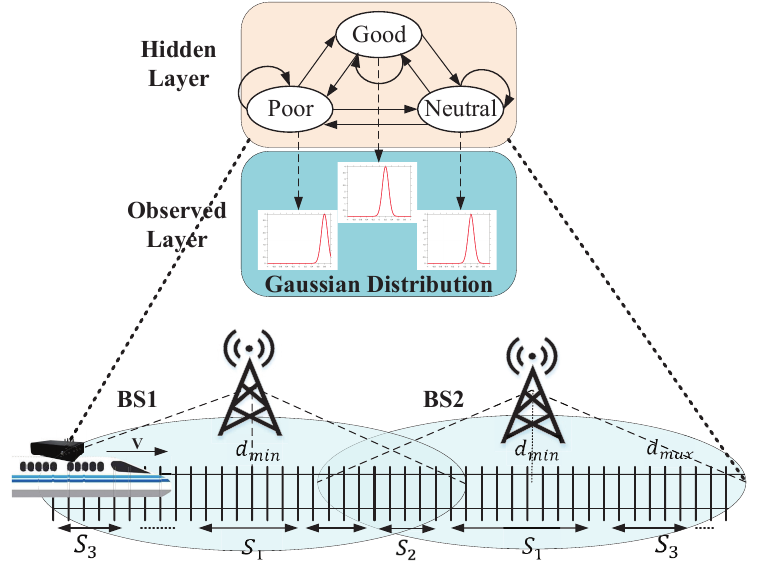
Figure 6. The estimation model of PLR. Solid lines with arrow in the hidden layer represent the state transition of the latent